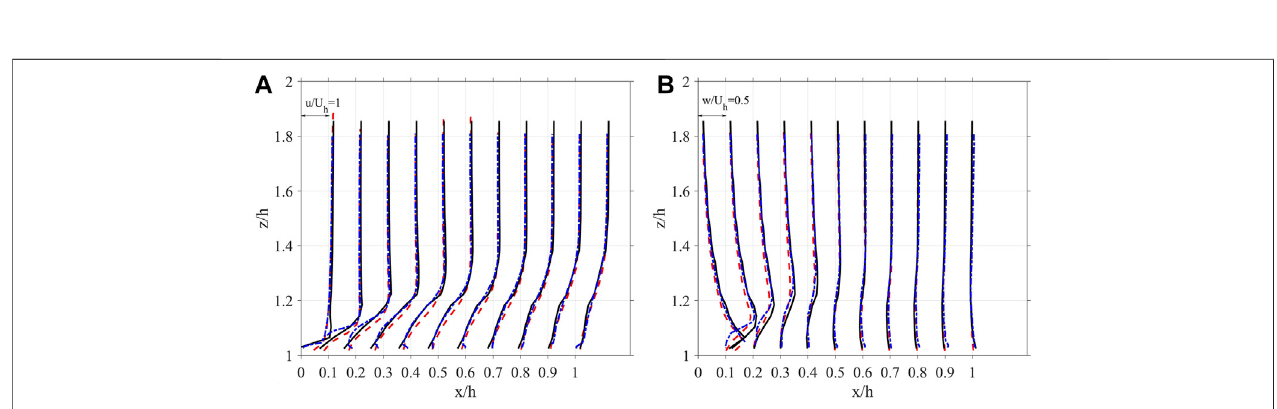
FIGURE 5 | Pro fi les of (A) the streamwise mean velocity; and (B) the vertical mean velocity in the fl ow model validation study; the experiment (blue dashed-dotted line), and simulation (red dashed line) of Lim et al. (2009) and the present simulation (solid line).